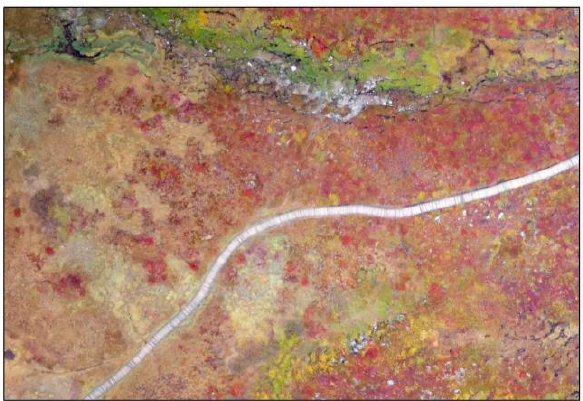
Figure 14. Detail of the Sermermiut old settlement – orthophoto in visible range from RPAS (Pavelka, Šedina,